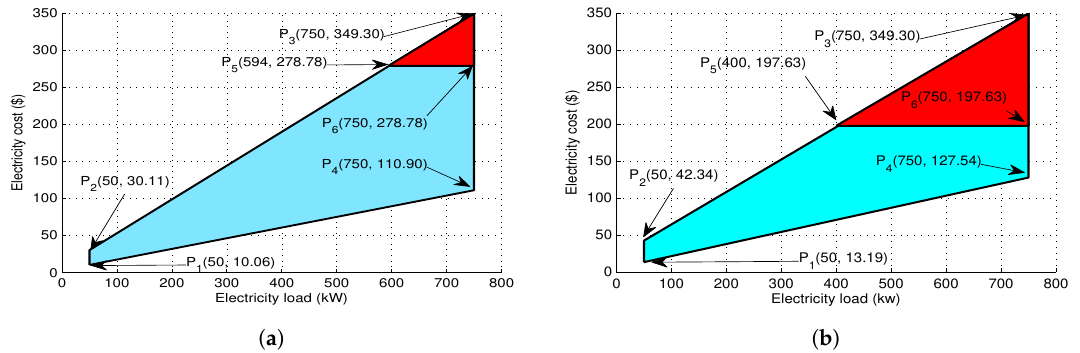
Figure 10. Feasible regions, ( a ) Feasible region for the GOA-scheduled load, ( b ) feasible region for the CSA-scheduled load.